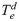
(a) Conceptual sketch representing the accumulation of information on the graph H. Whenever two pedestrians, say p1, p2 stand at a distance d smaller than D′, this gets recorded in the histogram weight of the edge between nodes p1 and p2 as an additive contribution to the bin approximating d. In the sketch we report a section of the platform: edge appear between nodes according to the distance; the histogram weights are reported atop and beneath the sketch with the same color coding of the edges and scaled with the sampling time (thus they translate to the contact time conditioned by the distance). Nodes are reported in red if they have performed at least one Corona event (thus they have an edge with non-zero contributions at distances below D′), else they are in green. (b) Examples of graphs acquired in windows of about ten minutes around each train arrival (determining the peaks in the counts at the bottom). We report a magnified version of one among these graphs. Nodes are colored by the node degree, i.e. by the number of first neighbors, ranging from yellow to red. Edge thickness scaled by the contact time, Ted, Eq (7). The higher the degree of a node, the larger the number of distance offenses performed by the associated pedestrian.